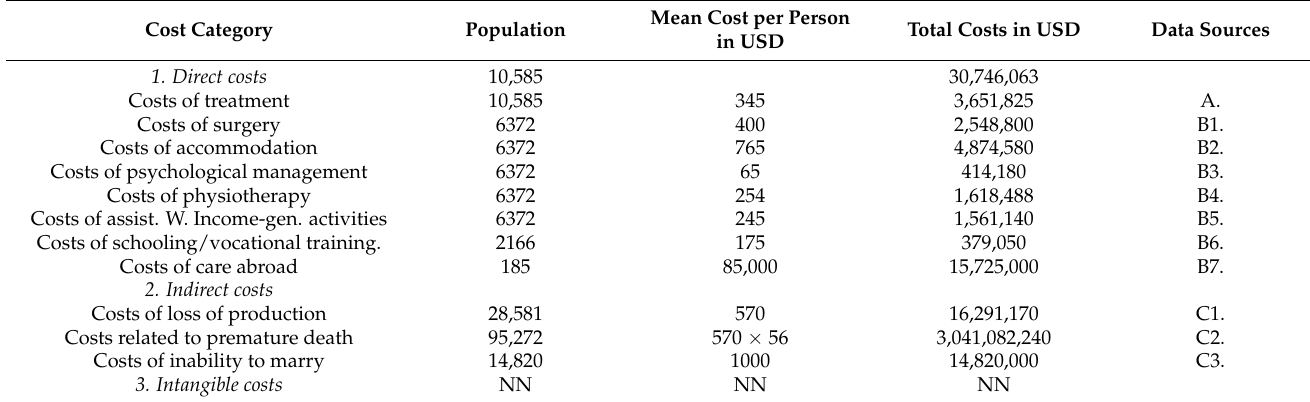
Table 5. Economic and social costs of noma in Niger in 2018.